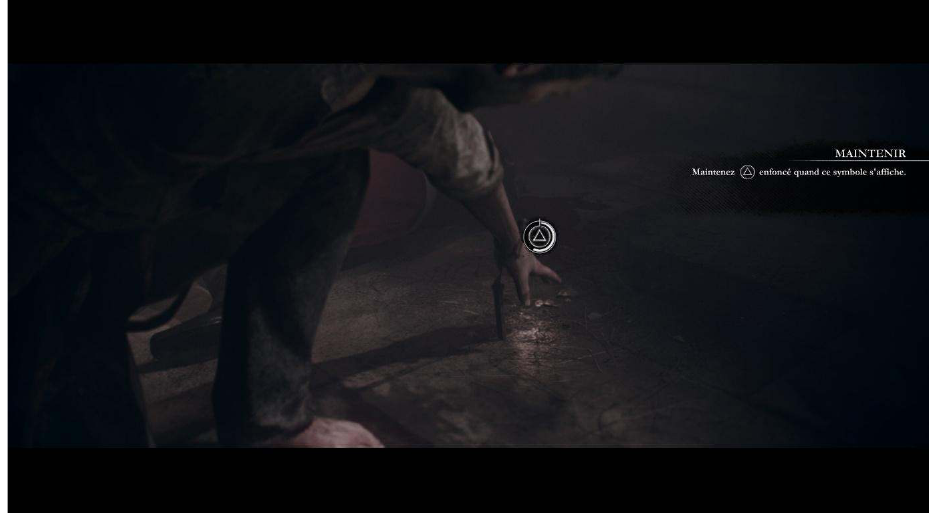
Here, the player has to keep pressing on the triangle to pick up an item during a